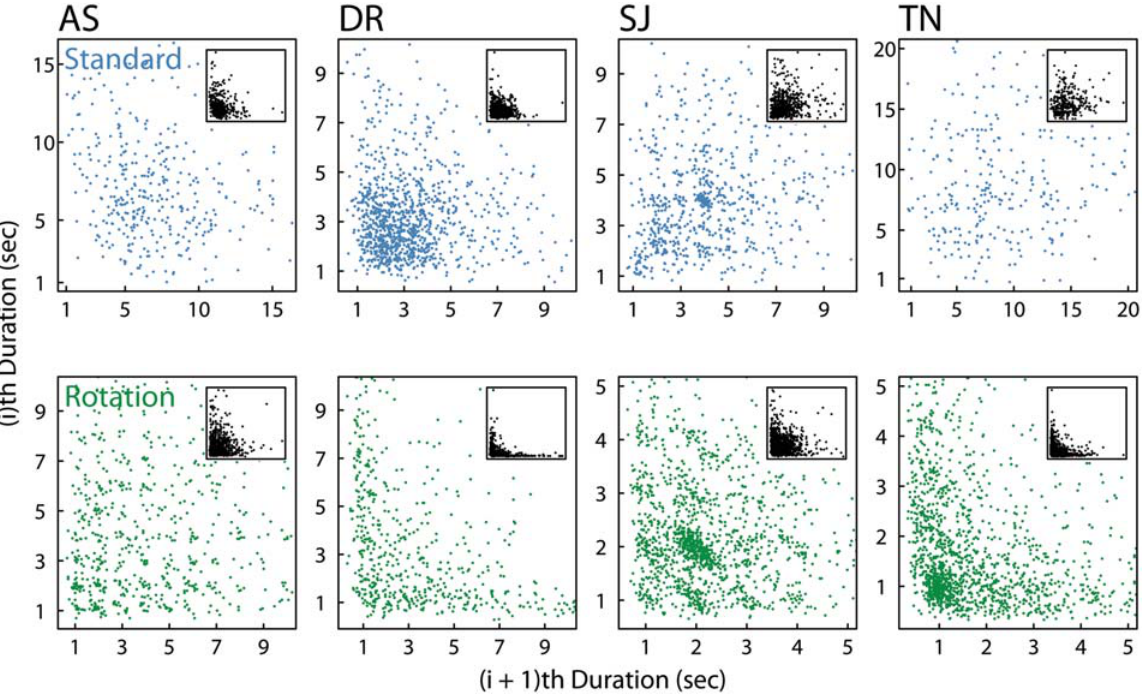
Figure 7. Lag plots. A simple method for checking randomness in percept duration data is the lag plot i.e. plotting the i th percept duration against the (i + 1) th duration. The plots present this data for each observer from Experiment 2 (combined across repetitions). The inset illustrates the entire duration distributions, with the main plots depicting the kernel of these distributions. doi:10.1371/journal.pone.0003982.g007 seen with the walker, two reversal location peaks emerged, with phases of the cuboid’s cycle (Switch to CW: x 2 = 62, df= 11, roughly 180 u of separation. These peaks were relatively stable p , 10 2 8 ; Switch to CCW: x 2 =210.5, df = 11, p , 10 2 15 ). However, in contrast to the single-peaked distributions generally across the three sessions. A similar distribution is apparent for SJ,